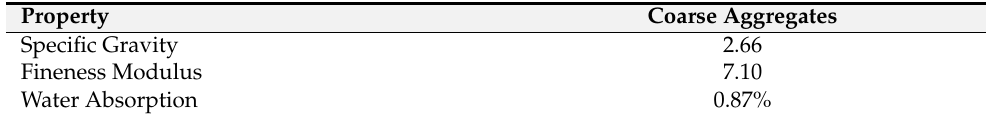
Table 3. Physical properties of coarse aggregates.